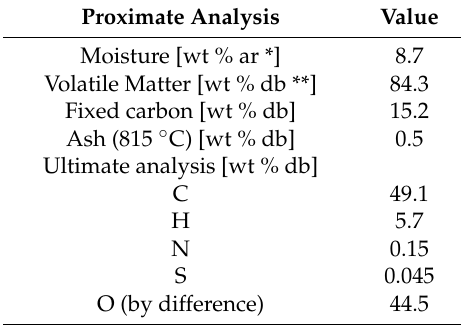
Table 1. Proximate and ultimate analyses of beech